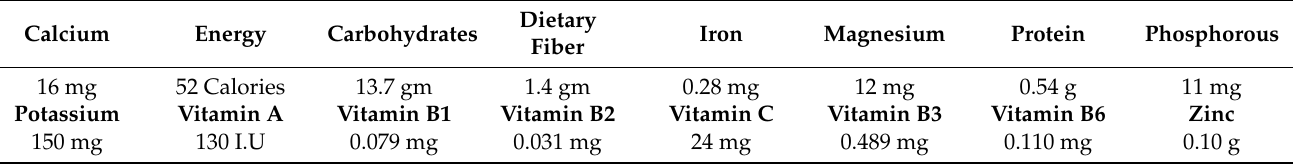
Table 3. Nutritional value in 100 g of